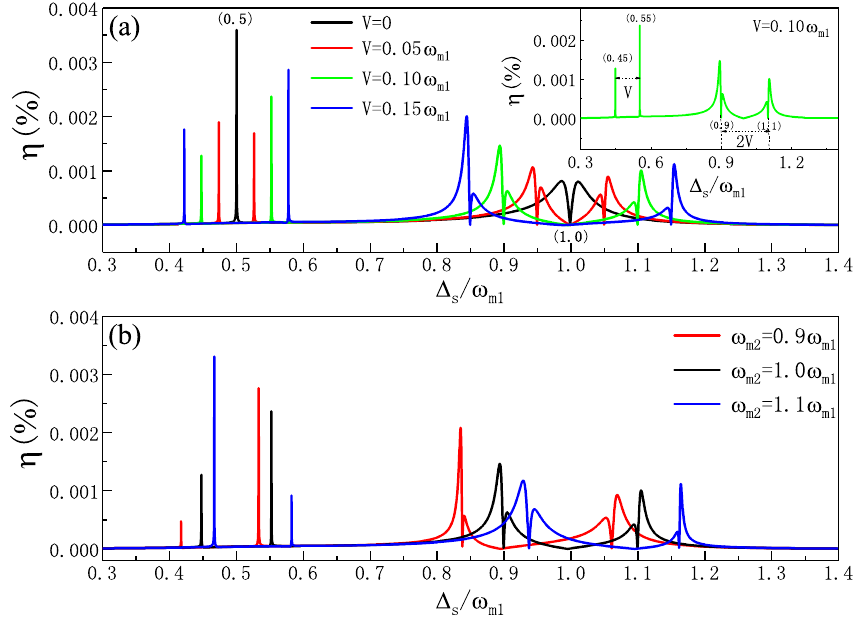
Figure 6. ( a ) The efficiency η of SSG four different coupling strengths V with the parameters of P c = 2.0 µ W and ω m 1 = ω m 2 at ∆ c = ω m 1 , and the inset gives V = 0.1 ω m 1 as an example. ( b ) The efficiency η of SSG as a function of ∆ s / ω m 1 for three different frequencies at P c = 2.0 µ W and V = 0.1 ω m 1